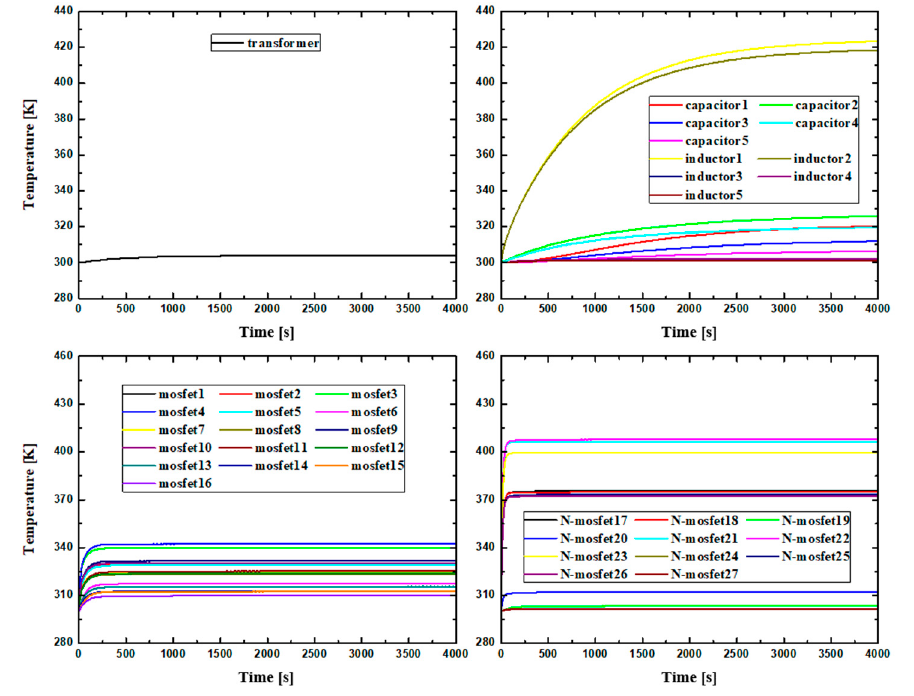
Figure 13. Temperature profile of the integrated module for a cooling water flow of 6 LPM in Operating Mode 3.